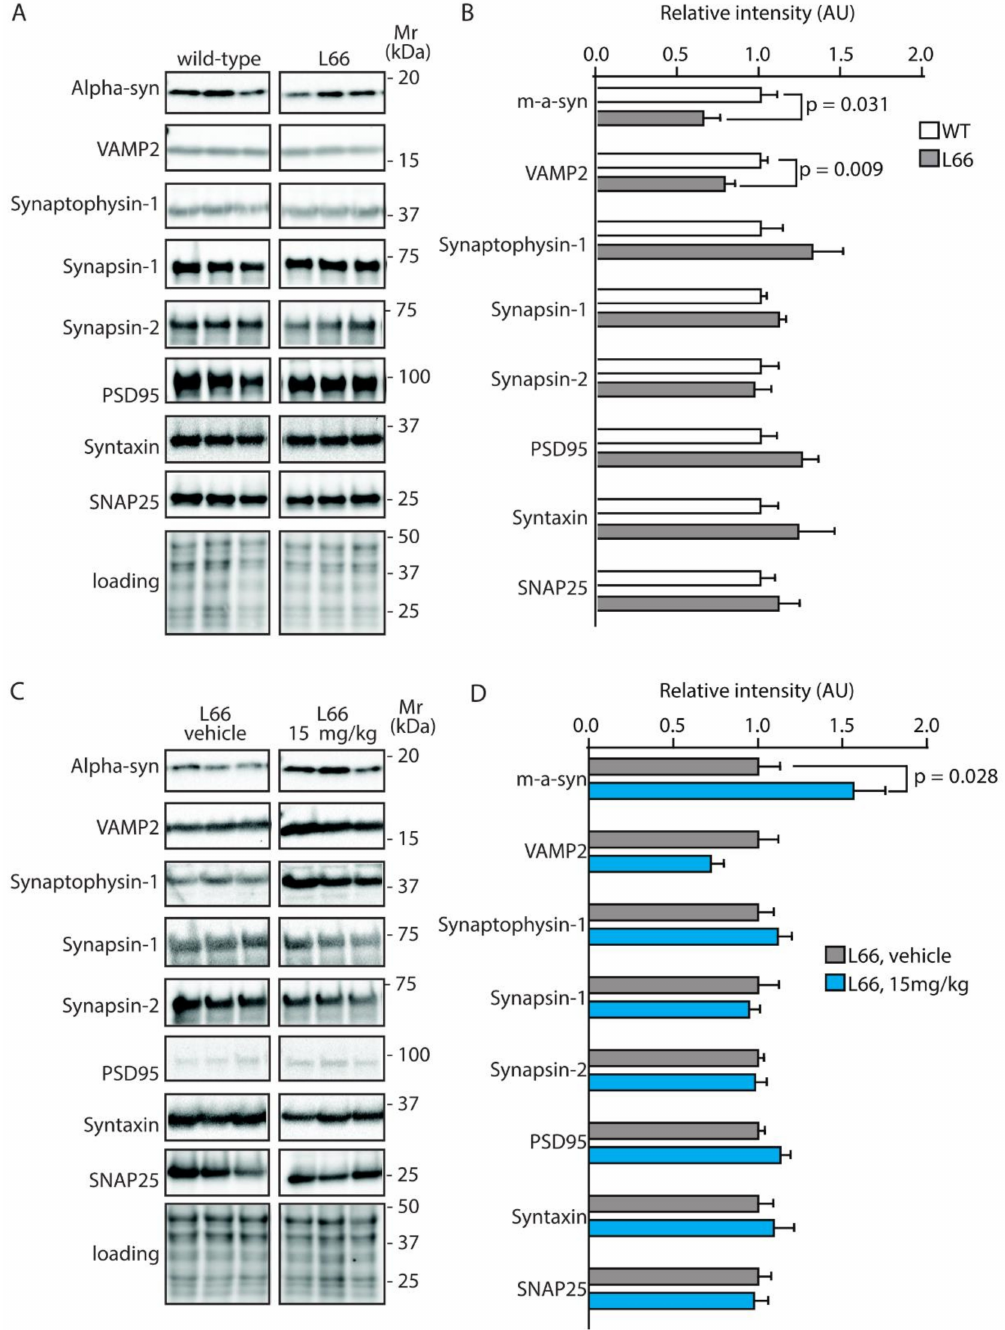
Figure 6. Quantification of synaptic proteins in mice. Representative immunoblots for ( A ) wild-type and L66 mice and ( C ) L66 mice treated with vehicle or LMTM (15 mg/kg). The proteins were separated by Tris-glycine SDS-PAGE and immuno-detection conducted using the antibodies specified. ( B , D ) Densitometric quantification of these proteins was normalised to total protein loading and values expressed as group mean ± S.E. Statistical analyses were conducted using unpaired t-test for n = 8–12 ( B ) and n = 11–14 mice ( D ) per group. WT: wild-type. Original blot images are provided in the Supporting